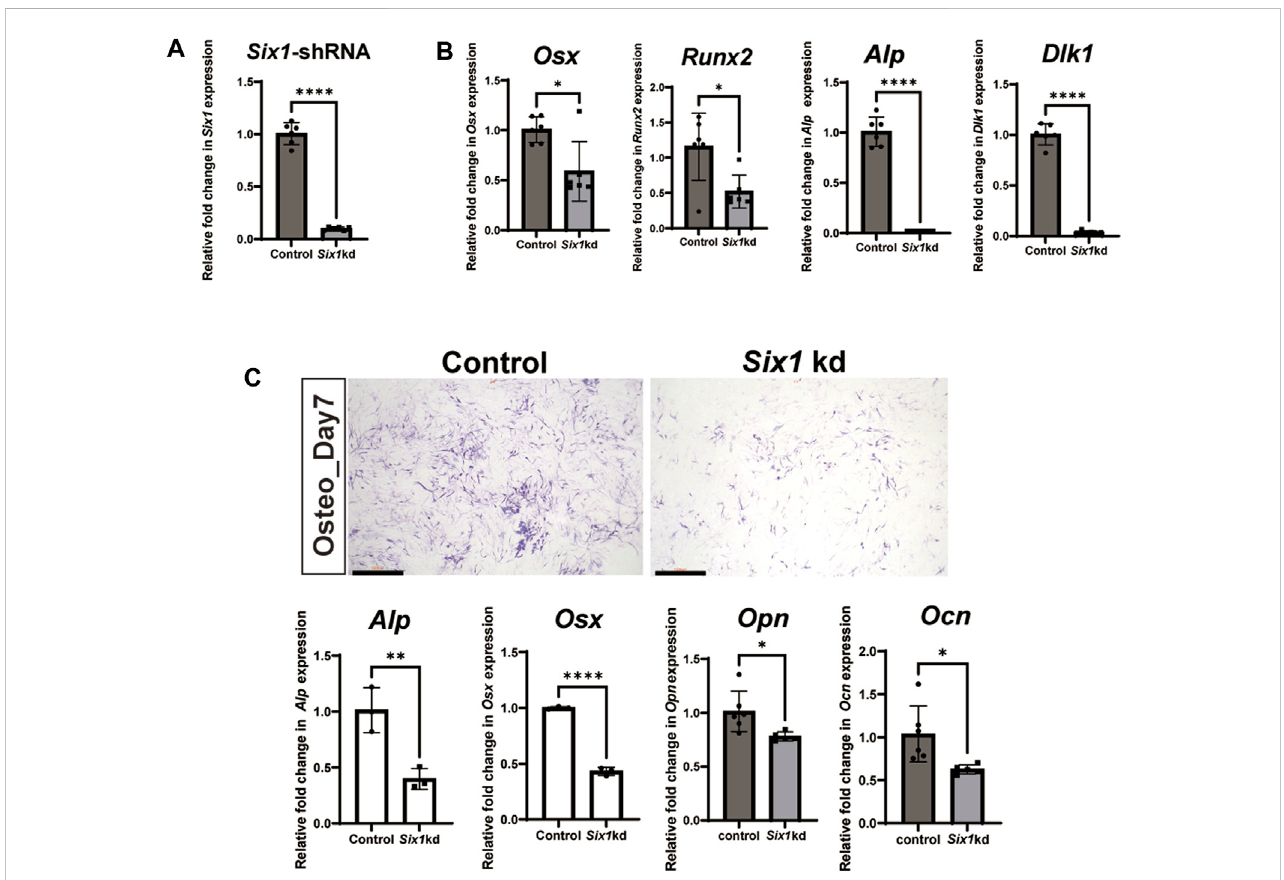
FIGURE 4 The effect of Six1 on the osteogenic differentiation of C3H10 T1/2 cells. (A) RT-qPCR analysis of C3H10 T1/2 cells transfected with negative control (Control) or Six1 knockdown cells ( Six1 kd) (n = 6). (B) RT-qPCR analysis of Osx , Runx2 , Alp , and Dlk1 in control and Six1 knockdown cells ( Six1 kd). (C) Alkaline phosphatase(ALP) staining ofnegative control C3H10 T1/2 cells (control) and Six1 kd cells after osteogenic inductionfor 7 days. RT-qPCR analysis of Alp , Osx , Opn , and Ocn after osteogenic induction for 7 days of control and Six1 kd cells. Scale bar in C, 1000